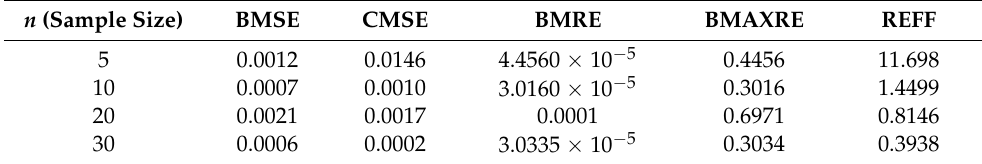
Table 12. Robustness: numerical results for case